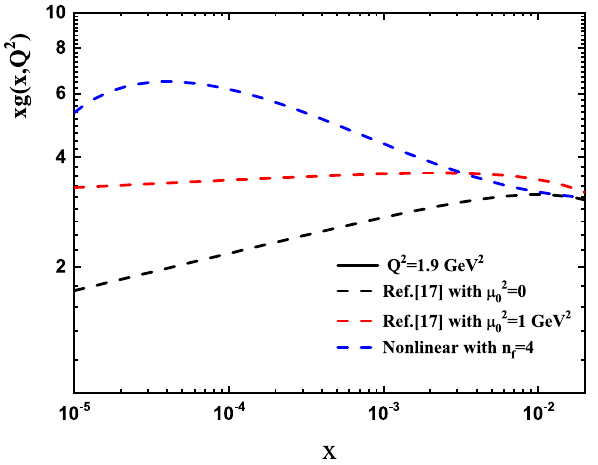
Fig. 2 The nonlinear gluon distribution function at R = 2 GeV − 1 and n f = 4 at Q 2 = 1 . 9 GeV 2 compared with the power corrections arises from the freezing of the running coupling with μ 2